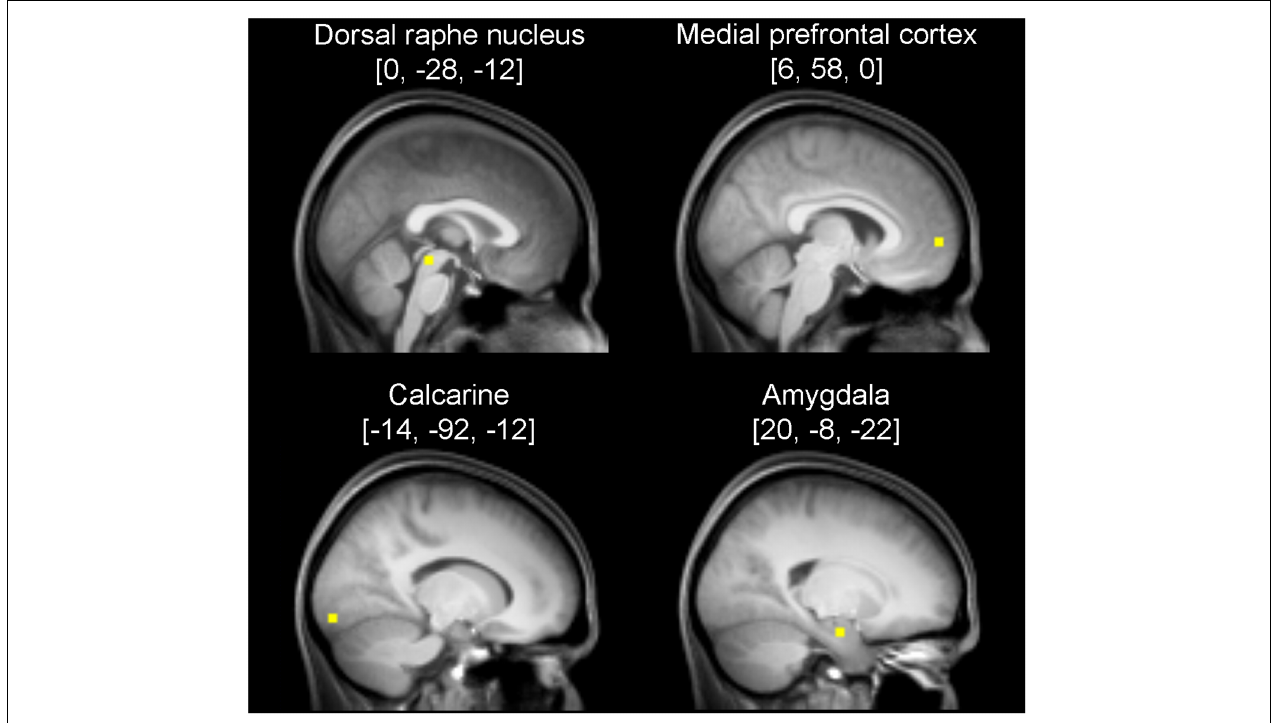
FIGURE 1 | Sagittal anatomical sections showing the volumes of interest (VOI) used for Dynamic Causal Modeling (DCM). The VOIs consisted of one voxel each, but for better illustration, spheres with a radius of 3 mm are shown. Coordinates refer to Montreal Neurological Institute space.